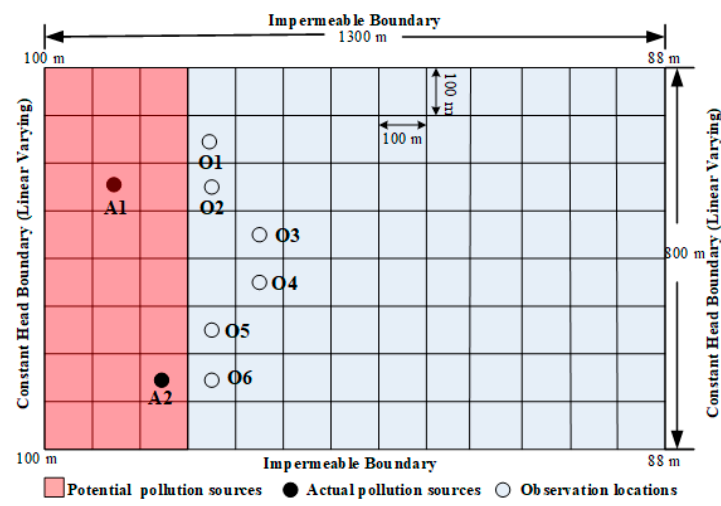
Figure 10. Distribution of potential pollution sources, actual pollution sources, and observation locations. Table 8. Concentrations and locations of actual pollution sources and observation locations for each stress period.